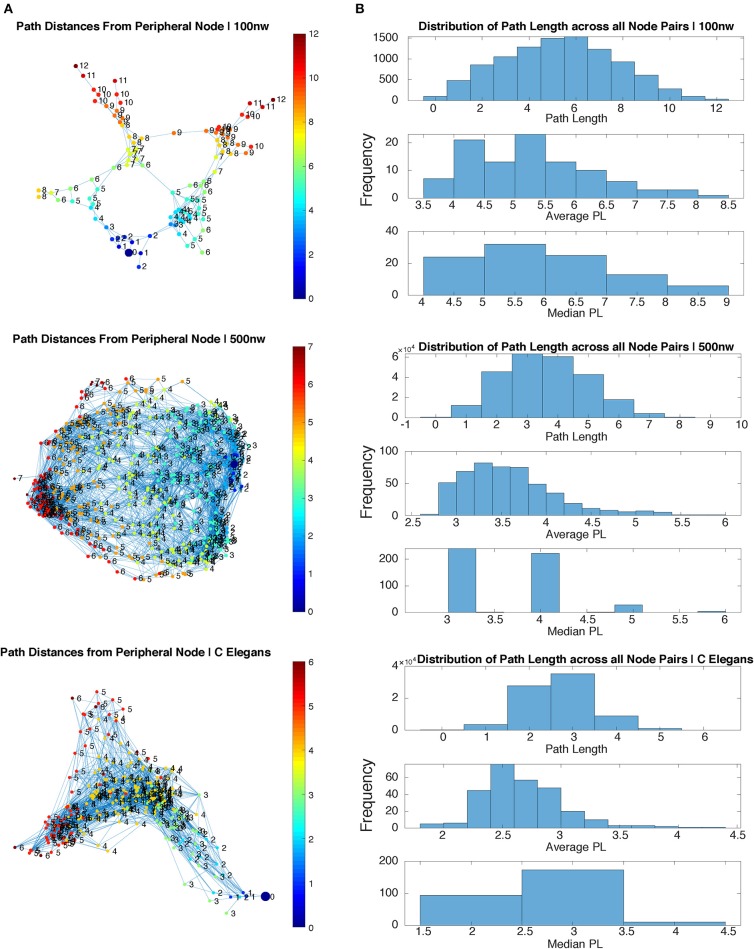
Path length comparison of sample 100 and 500 nw ASNs with C. elegans. (A) Path length of each node from a randomly selected peripheral node for sample 100, 500 nw and C. elegans networks. (B) Distribution of path lengths from all node pairs in each sample network, including the average and median path length distributions, for 100, 500 nw and C. elegans networks.